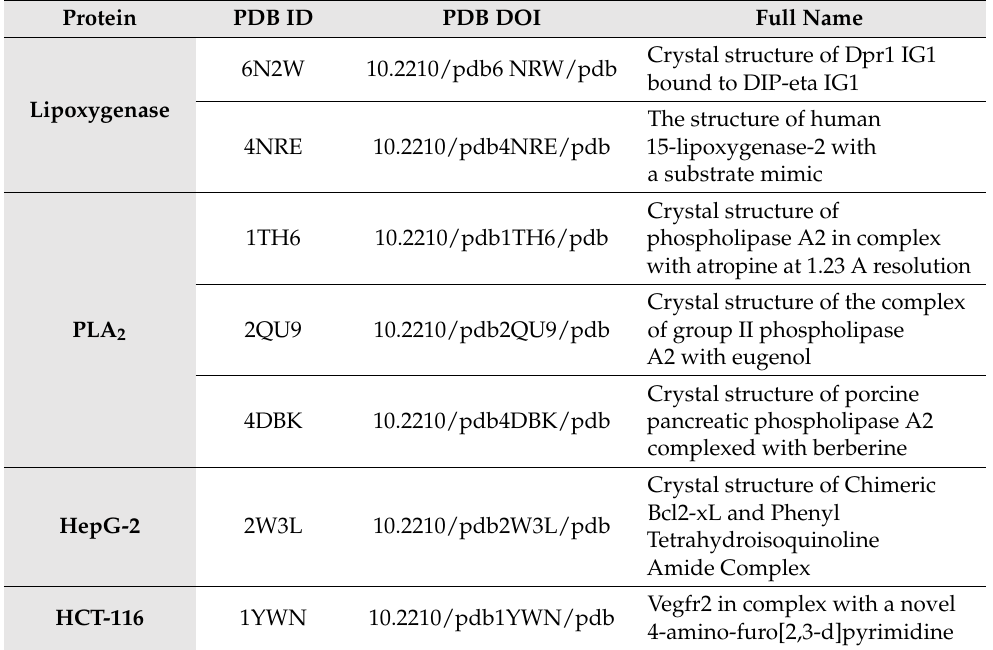
Table 13. PDB code with DOI references and full nomenclature of the studied proteins.